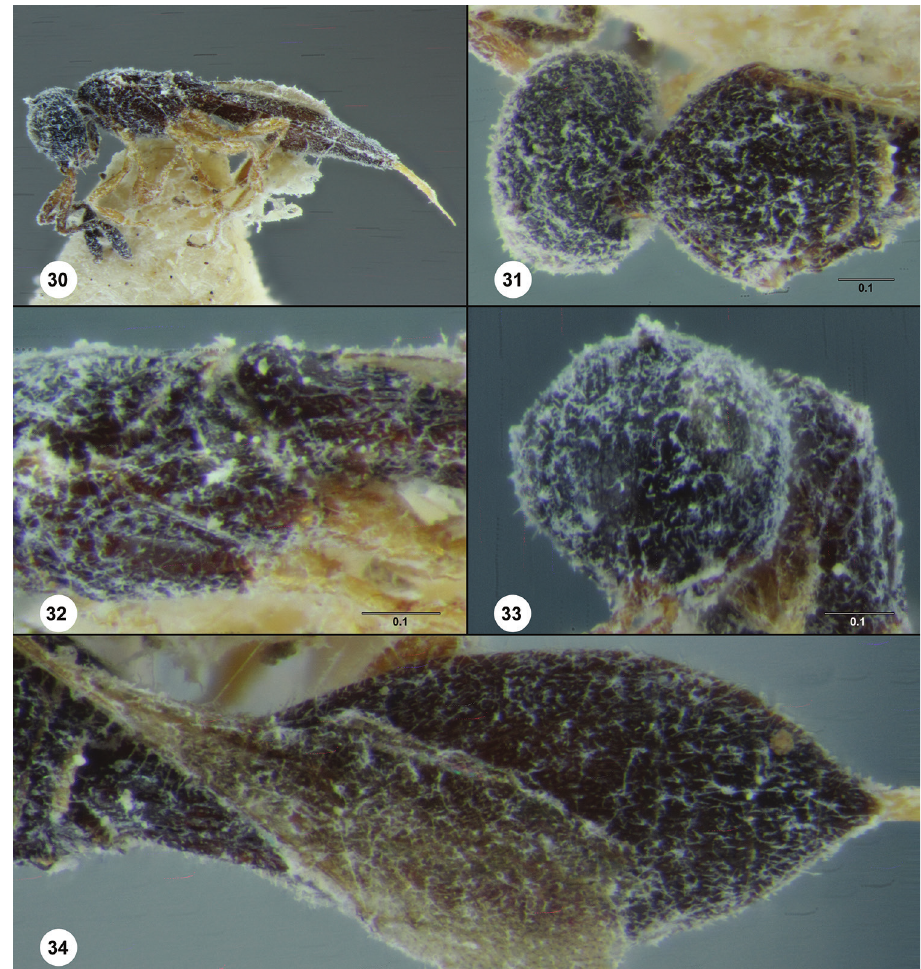
Figures 30–34. Paridris genaris , female holotype (IEBR 0105). 30 head, mesosoma, metasoma, lateral view 31 head and mesosoma, dorsal view 32 mesosoma and T1, dorsolateral view 33 head, anterolateral view 34 metasoma, dorsal view. Scale bars in